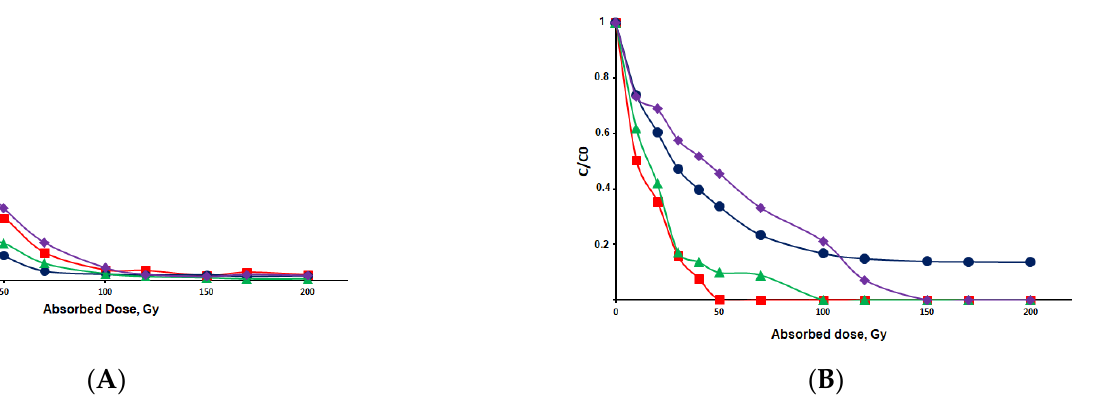
efficiency of 1 mg/L SER was less than 30%. The effluent is theoretically after the